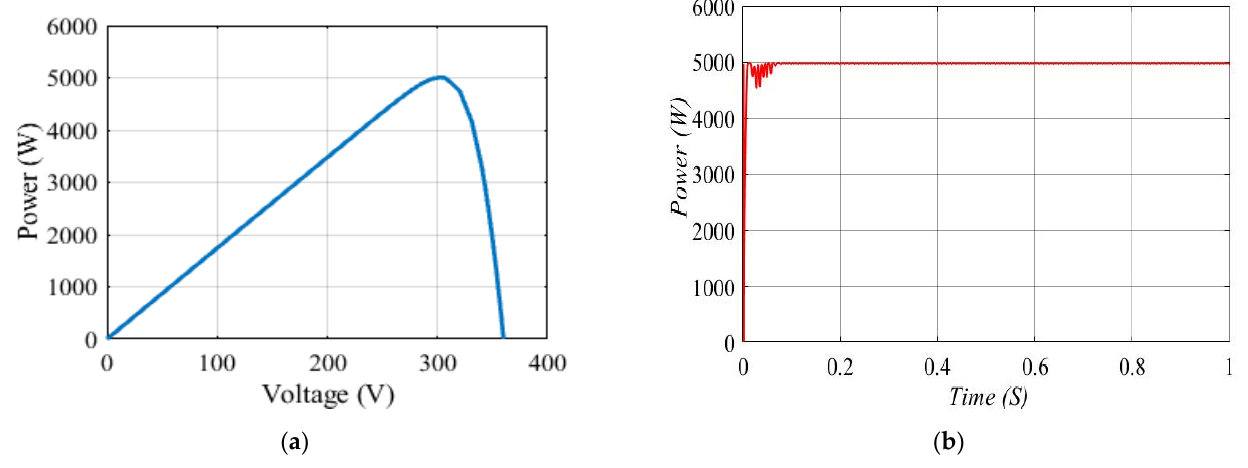
Figure 9. Details of actual power and proposed CSA-PID power under STC. ( a ) PV curve under STC (1000 W/m 2 and 25 °C). ( b ) The output power of proposed CSA-PID under STC.